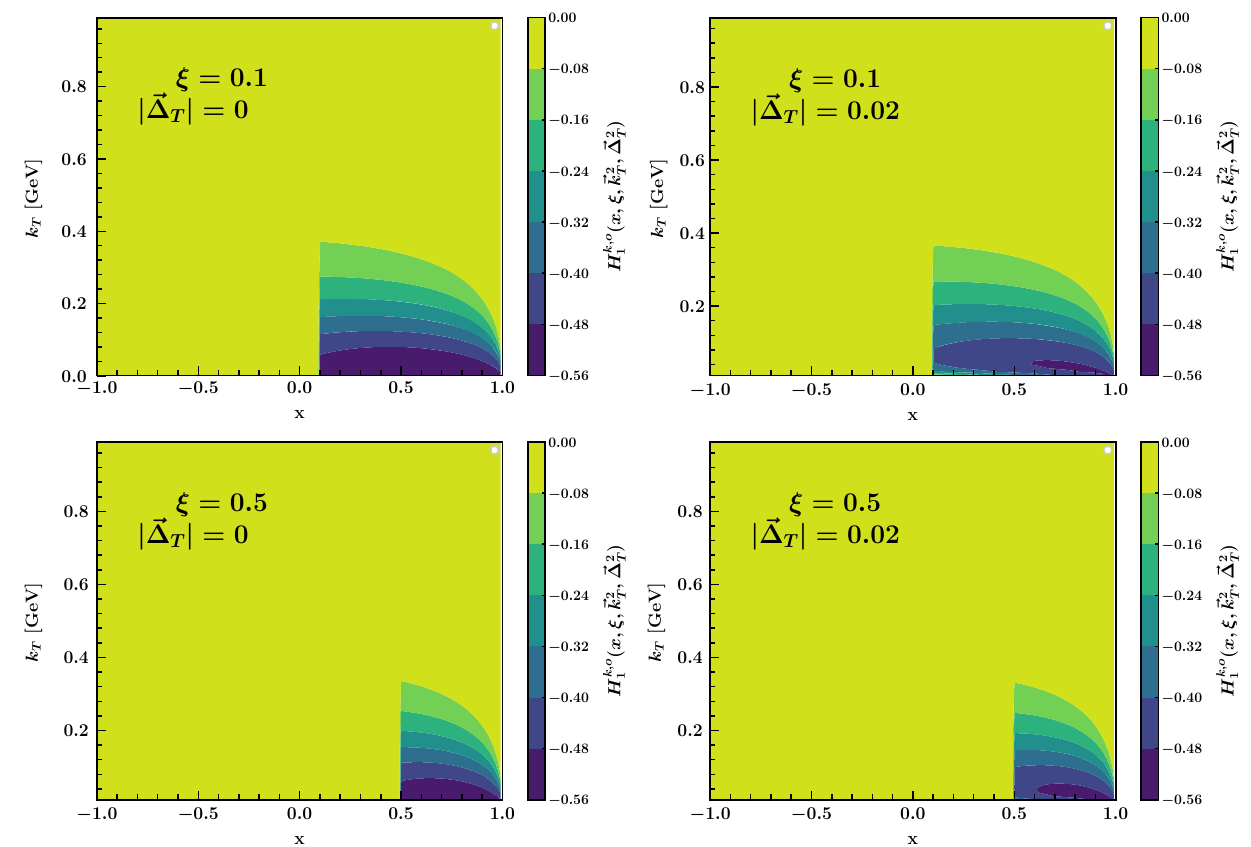
( x ,ξ, (cid:2) k 2 , (cid:2) (cid:3) 2 ) as functions of x and |(cid:2) k T T 1